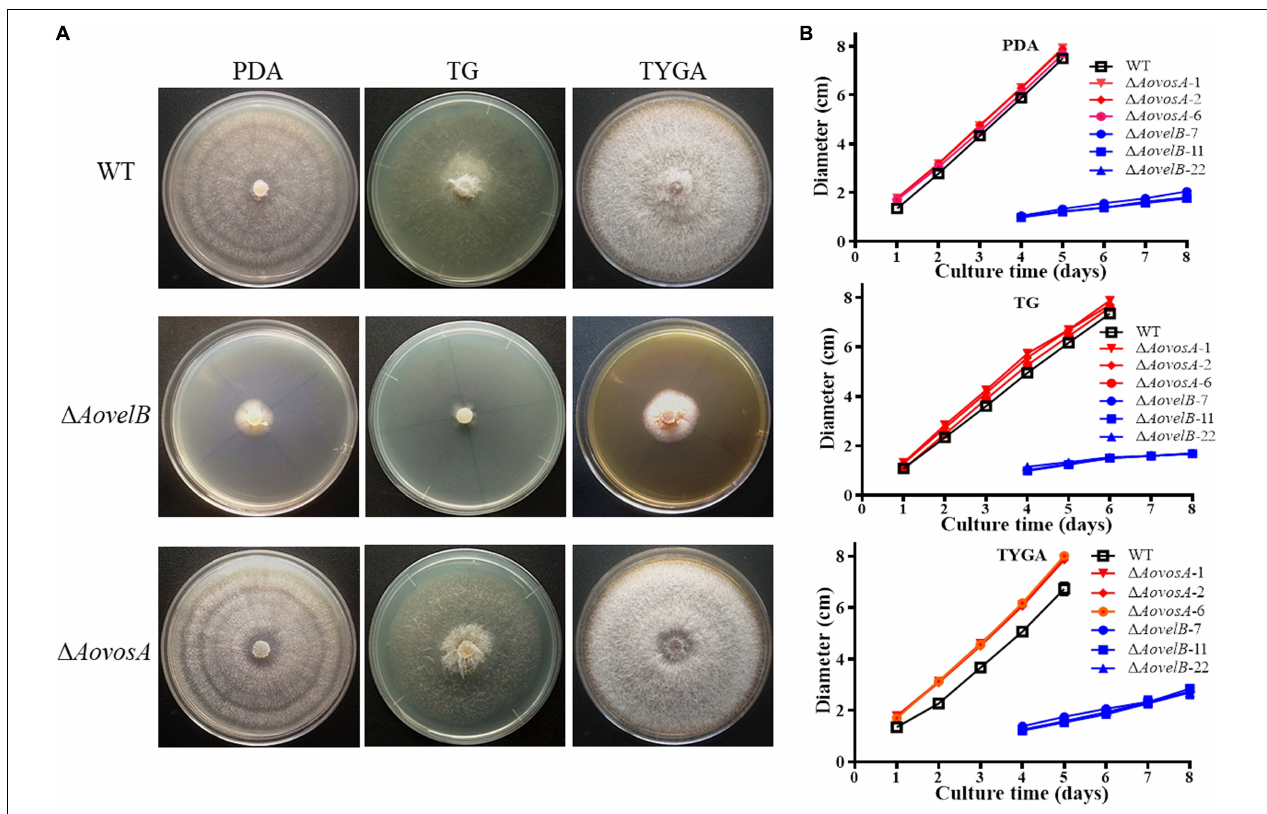
FIGURE 1 | Comparison of colony morphology and mycelial growth between the wild type (WT) and mutant lines. (A) Colonies from the WT and mutant lines were incubated on TYGA media for 5 days at 28 ◦ C. (B) Mycelial growth rates of the WT and mutants on PDA, TYGA, and TG plates.